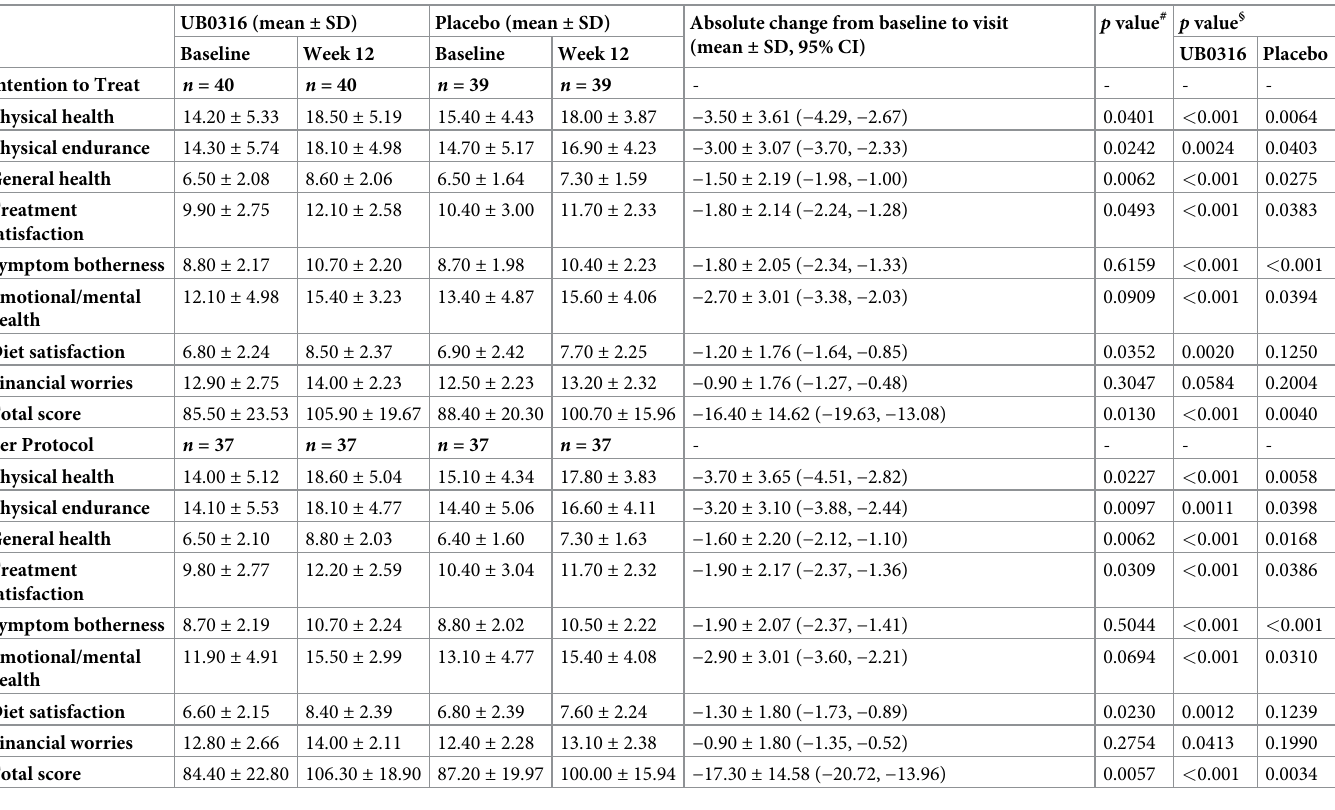
Table 3. Quality of life assessment of the Intention-to-Treat and Per Protocol